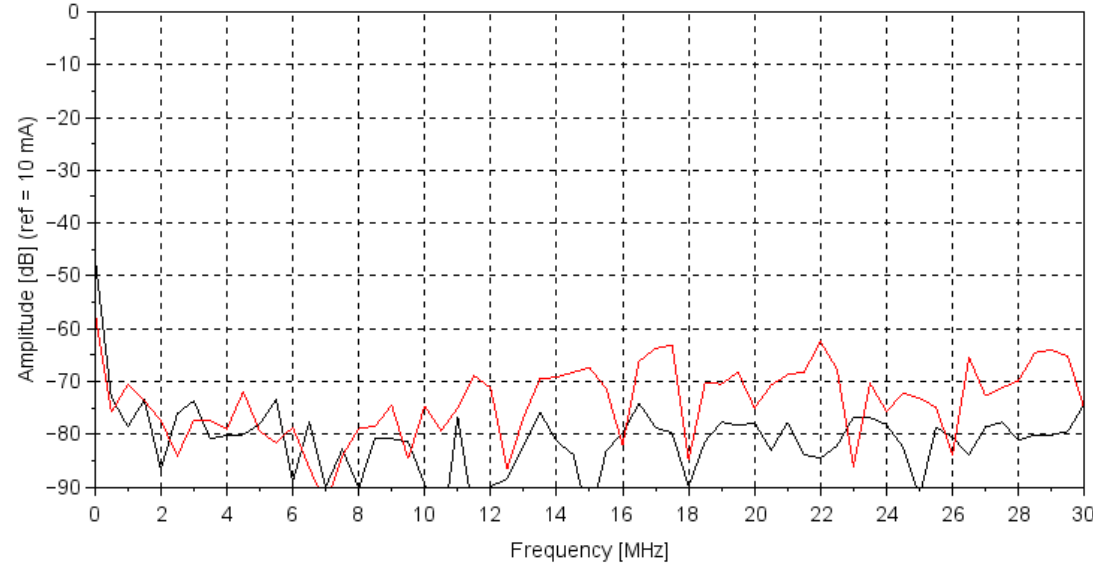
Figure 6. Figure showing the 1 kpts frequency spectra of signals with no arc (black) and with the arc (red).